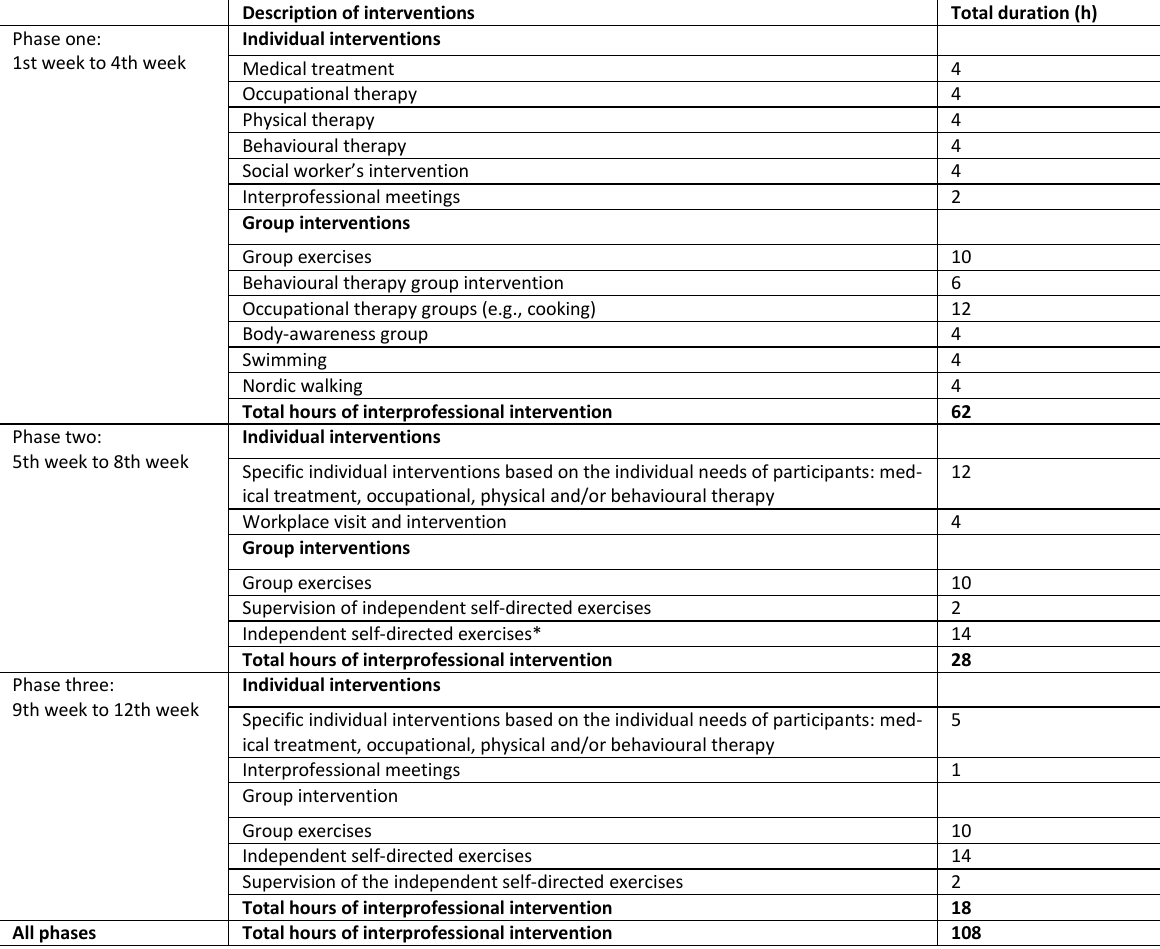
Table 1: Content of interprofessional intervention in BAI-Reha phases one to three: description and intensity of interventions. Description of interventions Phase one: 1st week to 4th